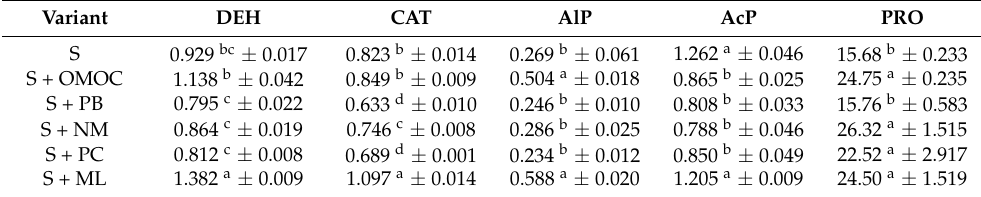
Table 6. The activity of enzymes in